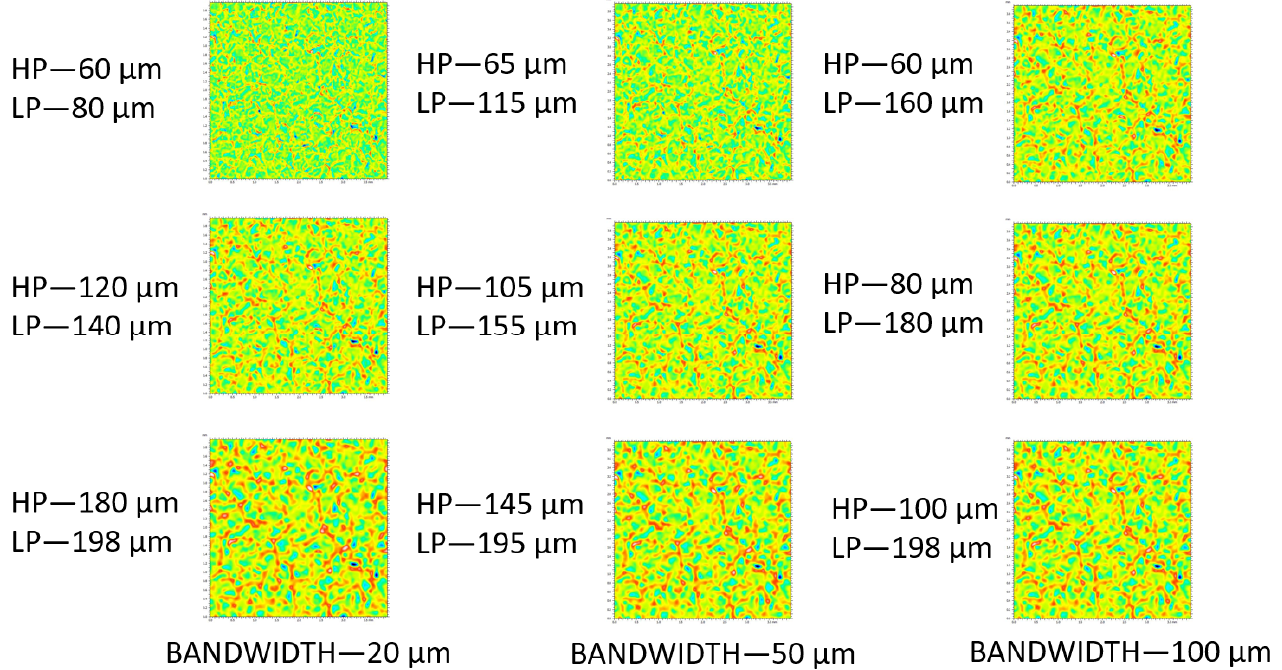
Figure 5. Renderings of bandpass filtered topographies at the upper location of Specimen A using three different bandwidths: 20, 50, and 100 µm. Please note that HP and LP stand for cut-off wavelengths of high- and low-pass filters, respectively.